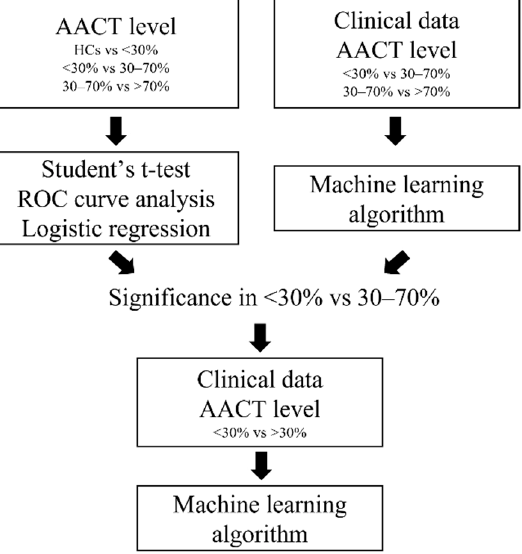
Figure 3. The flowchart of proposed method in this